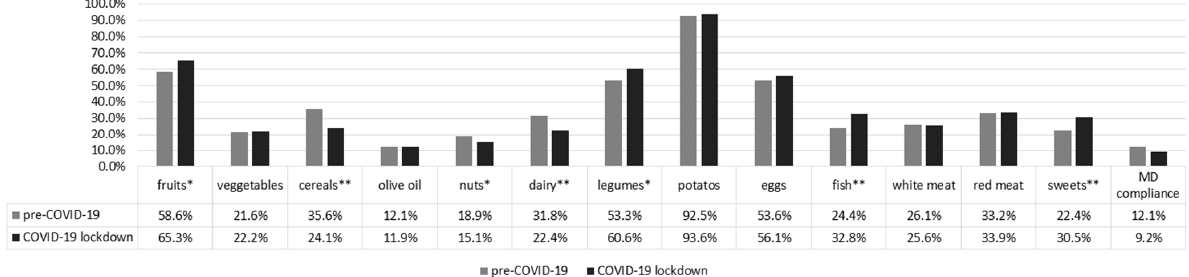
Figure 1. Adherence to the Mediterranean diet pyramid food groups according to the Mediterranean diet score, excluding wine due to subjects’ age [24] and the overall Mediterranean diet (MD) adherence (** p < 0.001, * p < 0.05).